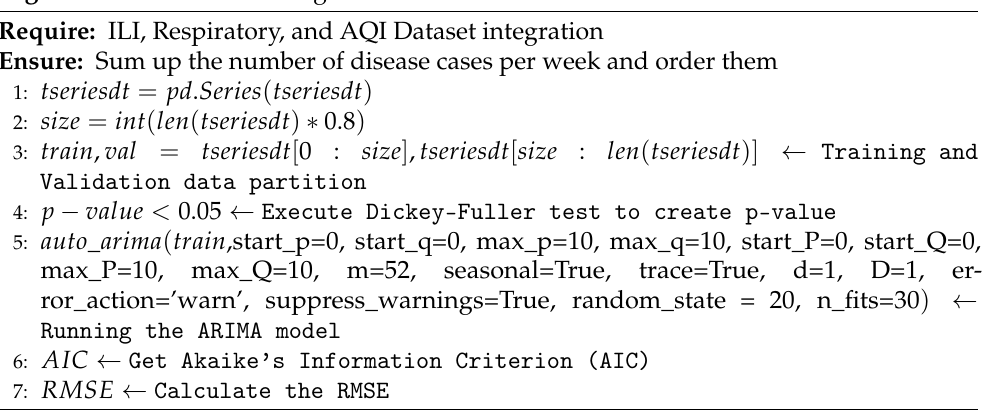
Algorithm 1 ARIMA Training